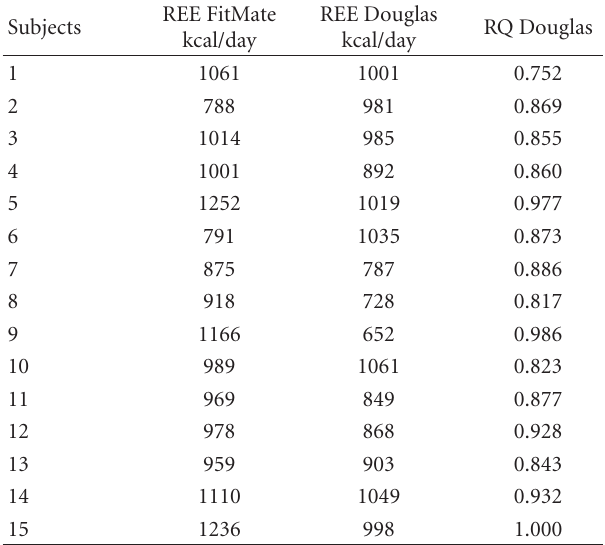
Table 2: REE measured in each participant with FitMate and Douglas bag together with individual values of